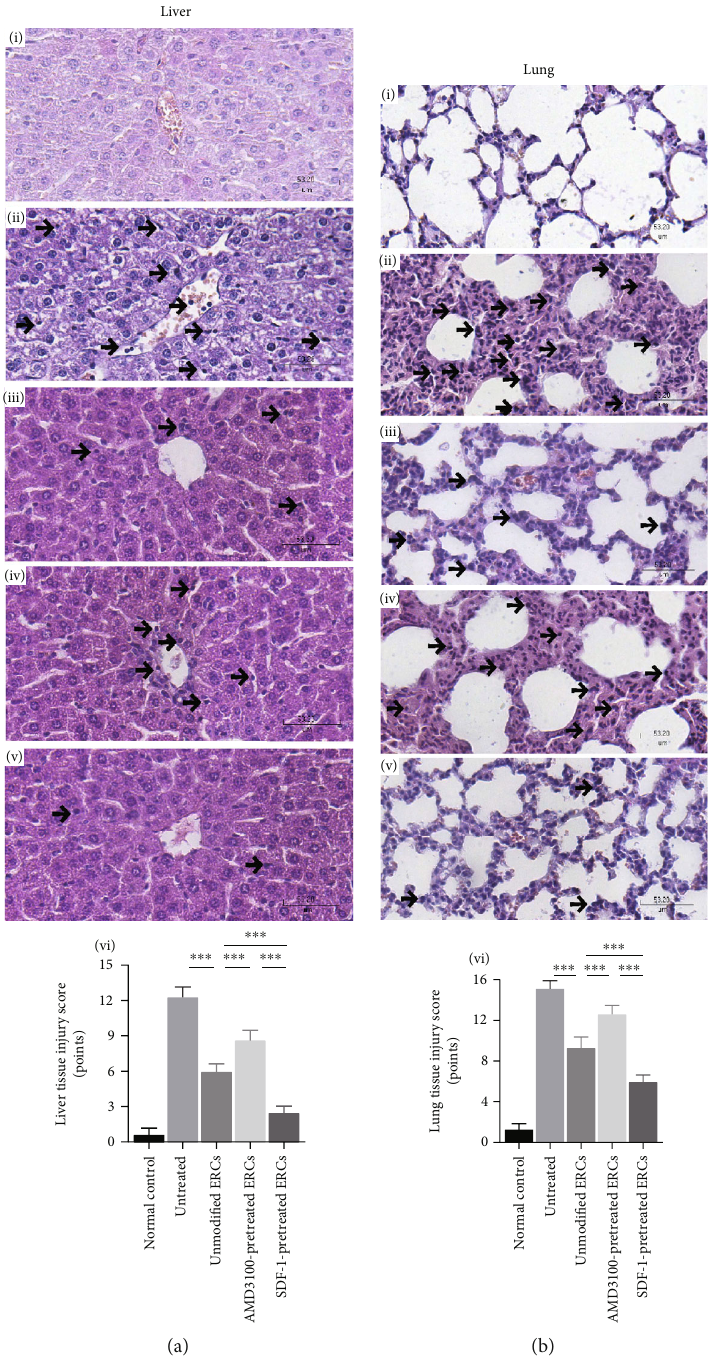
Figure 2: Pretreatment with SDF-1 on ERCs further ameliorated pathological changes. (a) Liver H&E-stained images are displayed at 400x magni fi cation. Arrows indicate in fl ammatory cell in fi ltration. (i) Normal control group, (ii) untreated group, (iii) unmodi fi ed ERC group, (iv) AMD3100-pretreated ERC group, (v) SDF-1-pretreated ERC group, and (vi) the liver pathological scores. SDF-1-pretreated ERC group exhibited less ballooned hepatocytes and in fi ltration of in fl ammatory cells. (b) Lung H&E-stained images are displayed at 400x magni fi cation. Arrows indicate in fl ammatory cell in fi ltration. (i) Normal control group, (ii) untreated group, (iii) unmodi fi ed ERC group, (iv) AMD3100-pretreated ERC group, (v) SDF-1-pretreated ERC group, and (vi) the lung pathological score. SDF-1-pretreated ERC group exhibited less edema, interstitial in fl ammation, and necrosis. Statistical analysis was performed by one-way analysis of variance (ANOVA), and the posttest was the least signi fi cant di ff erence (LSD) test, n = 6 . ∗ p < 0 : 05 , ∗∗ p < 0 : 01 , and ∗∗∗ p < 0 : 001 . Bar graphs represent mean ± SD . Abbreviation: ERCs: endometrial regenerative